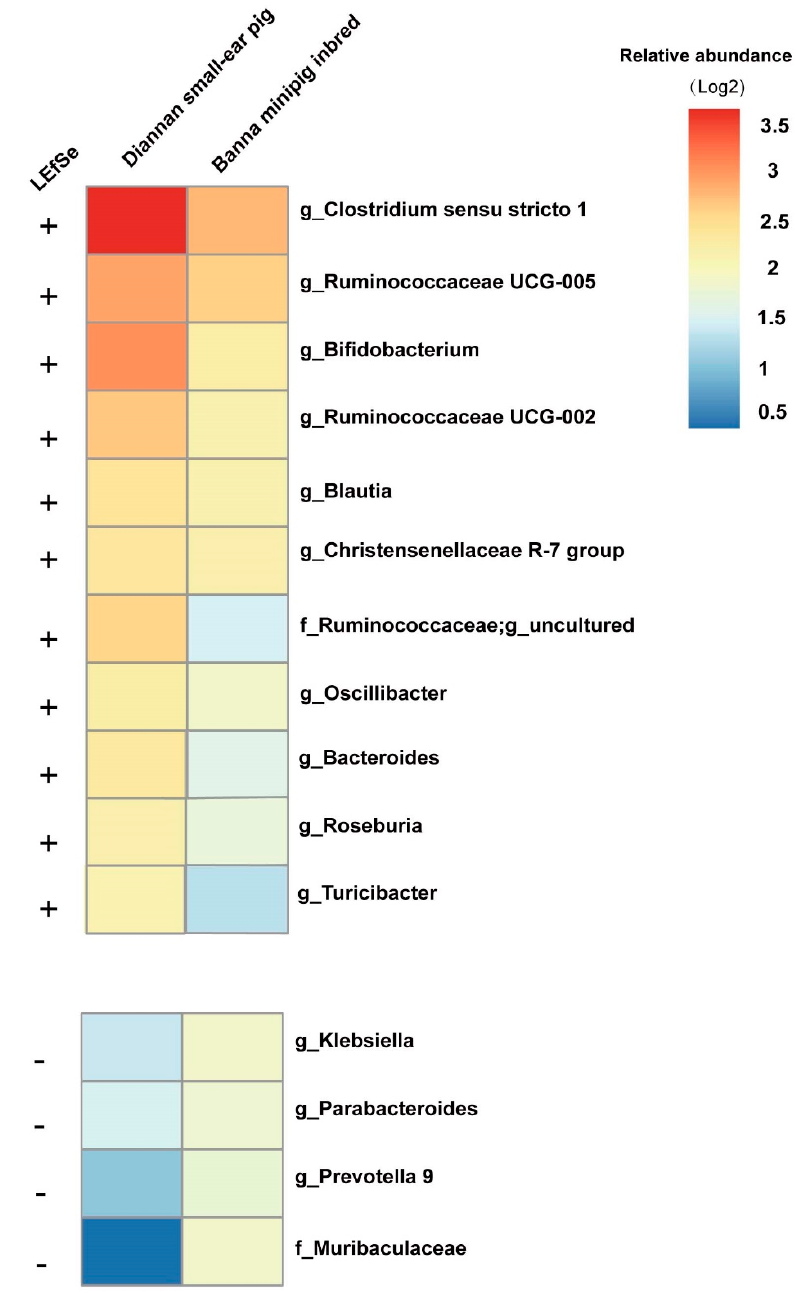
Figure 4. Gut bacterial taxa found to be significantly associated with Diannan small-ear pig and Banna minipig inbred. The average relative abundance of the LEfSe-identified taxa in the Diannan small-ear pig and Banna minipig inbred is plotted as a heatmap. “+” indicates significantly high abundance in Diannan small-ear pig, “ − ” significantly high abundance in Banna minipig inbred ( p < 0.05, LDA cutoff = 2.0).